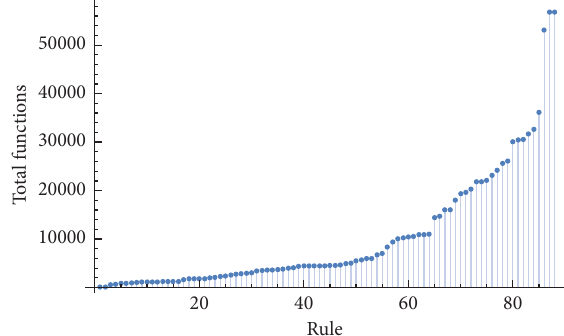
Figure 2: Number of functions induced by environments on enclosed volumes for environment thicknesses and volume sizes from 1 to 7. All 88 unique rules.